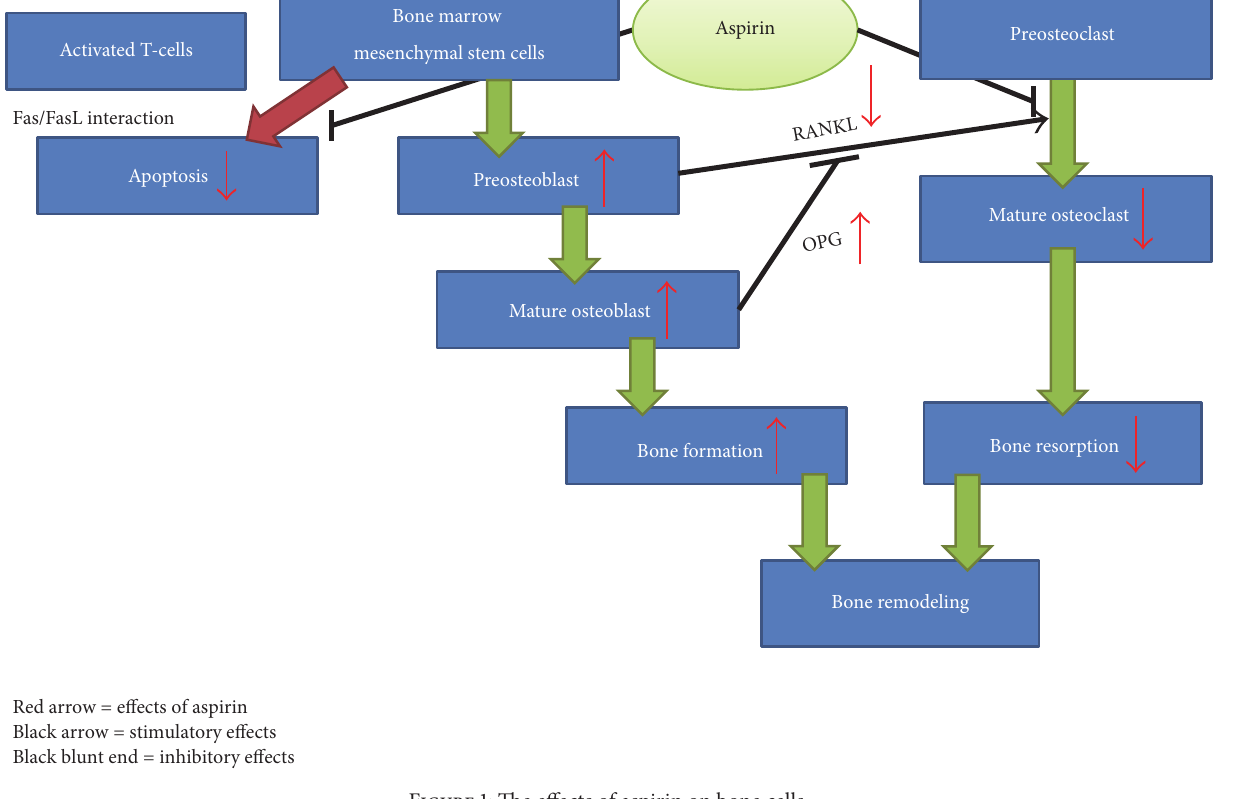
Figure 1: The effects of aspirin on bone